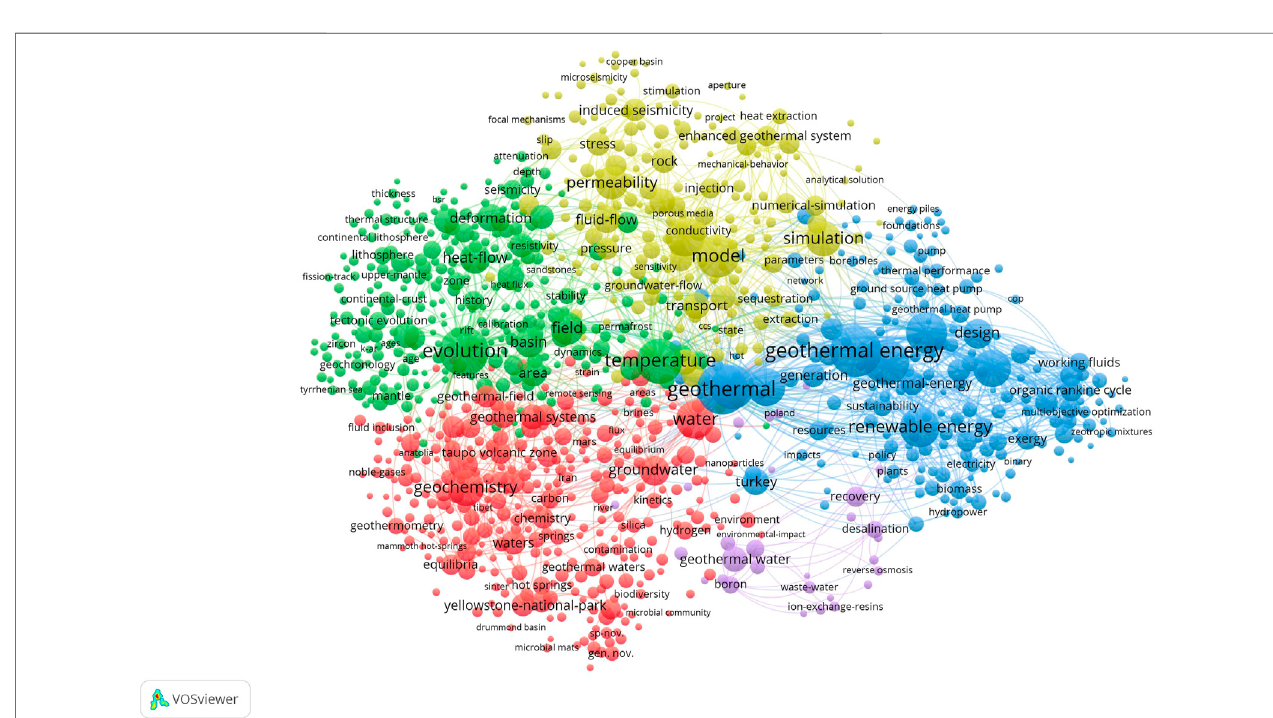
FIGURE 8 | Co-occurrence mapping of keyword "geothermal+geothermal energy".